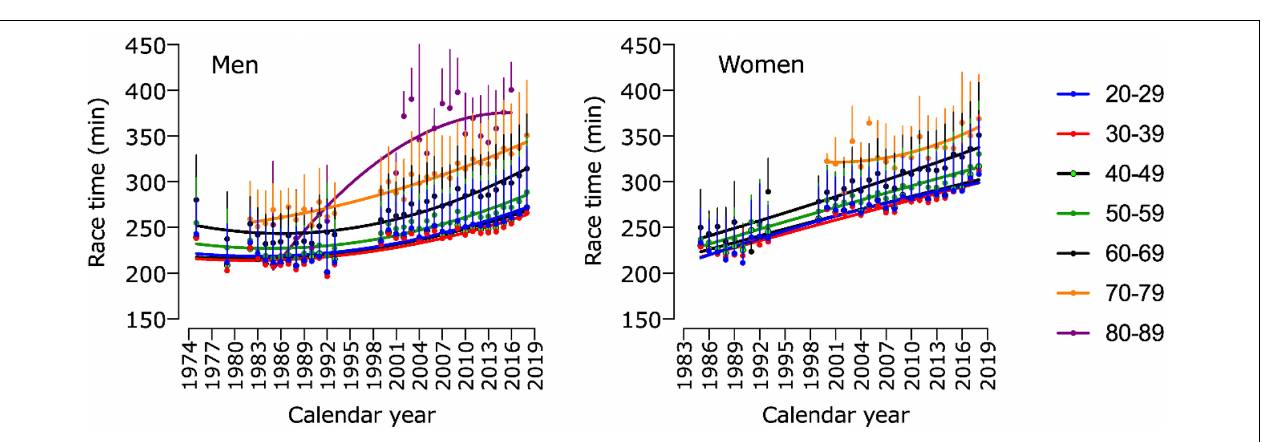
FIGURE 4 | Race time of men and women in “Berlin Marathon” in age groups across calendar